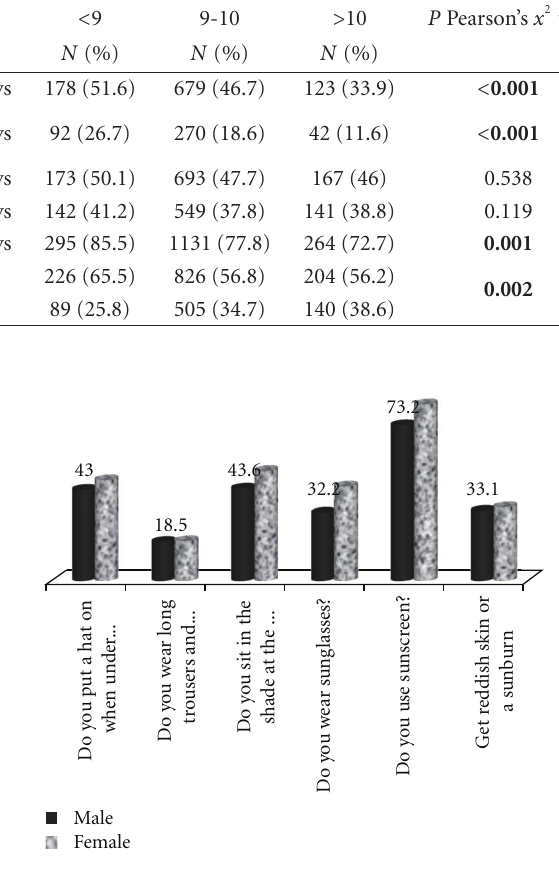
Figure 2: Students’ behaviour according to